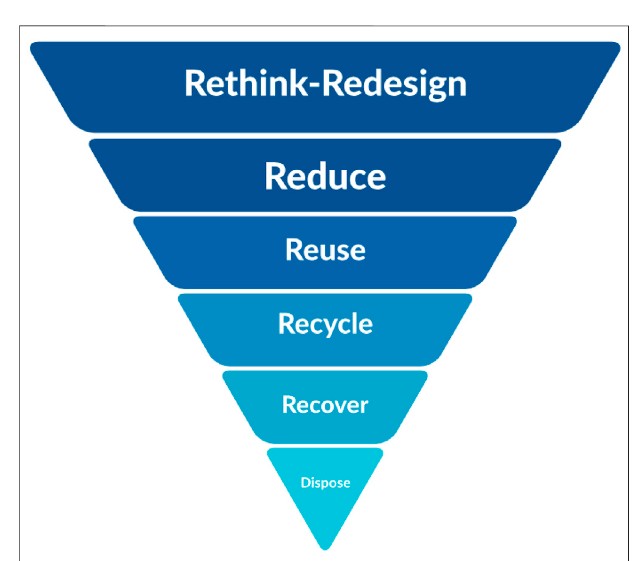
FIGURE 6 | Ideal waste management hierarchy in